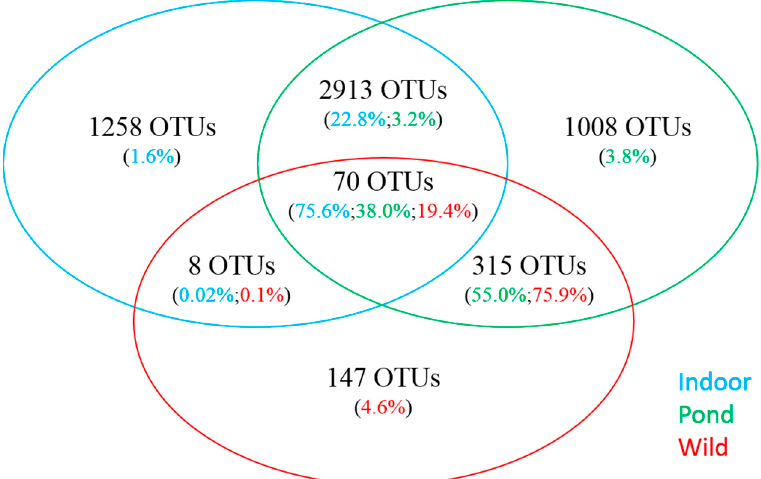
Figure 1. Venn diagram showing the number of shared and unique OTUs from the intestine of indoor- raised, pond-reared and wild caught white leg shrimp. Also shown is the proportion of sequence reads for each category. Table 3. Relative abundance (%) of main bacterial taxonomic groups in the intestinal tract of whiteleg shrimp raised under two different production systems and from a wild